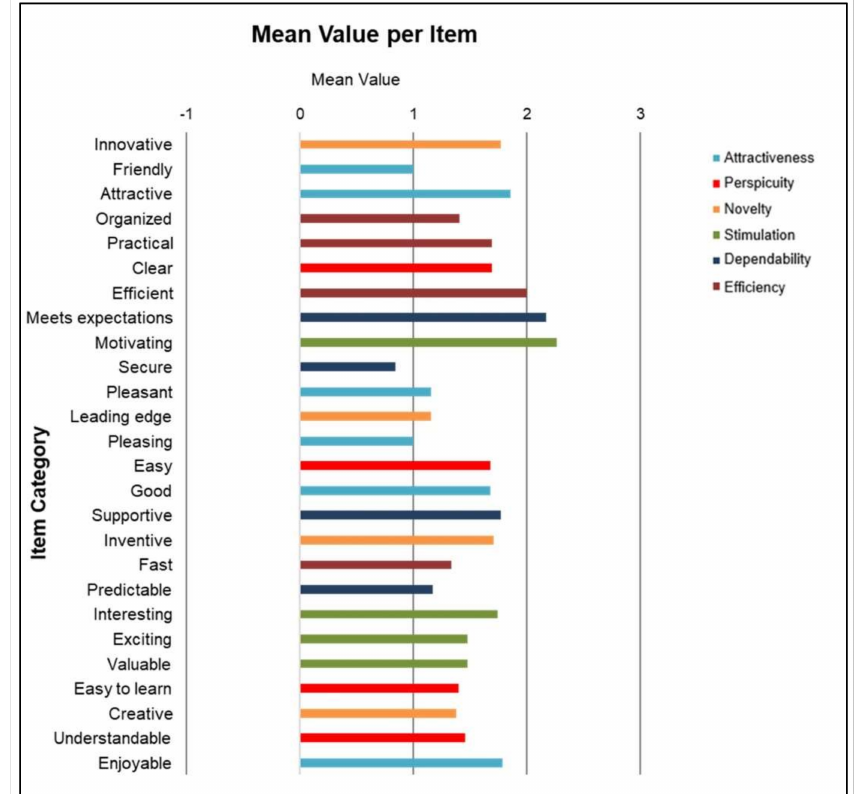
Figure 14. Scale mean value per item for multi-aspect user experience (UX)